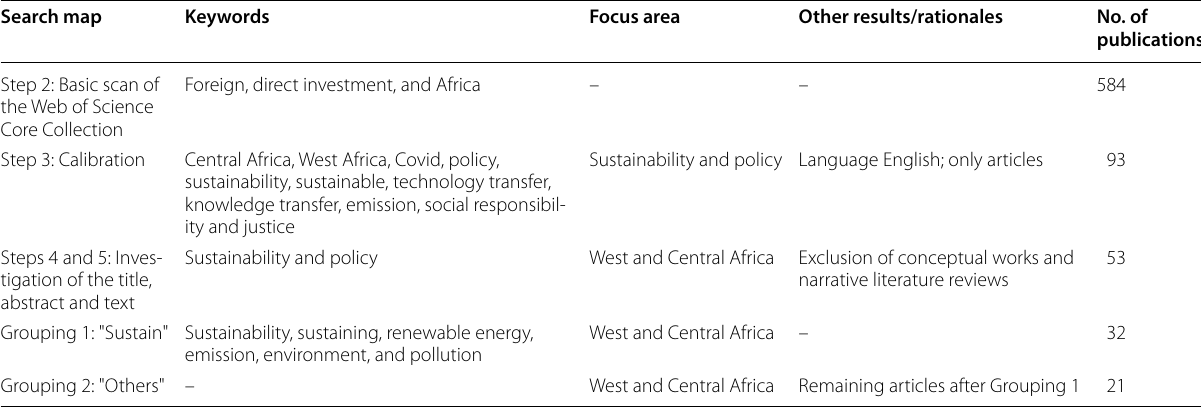
Table 1 Search filters and